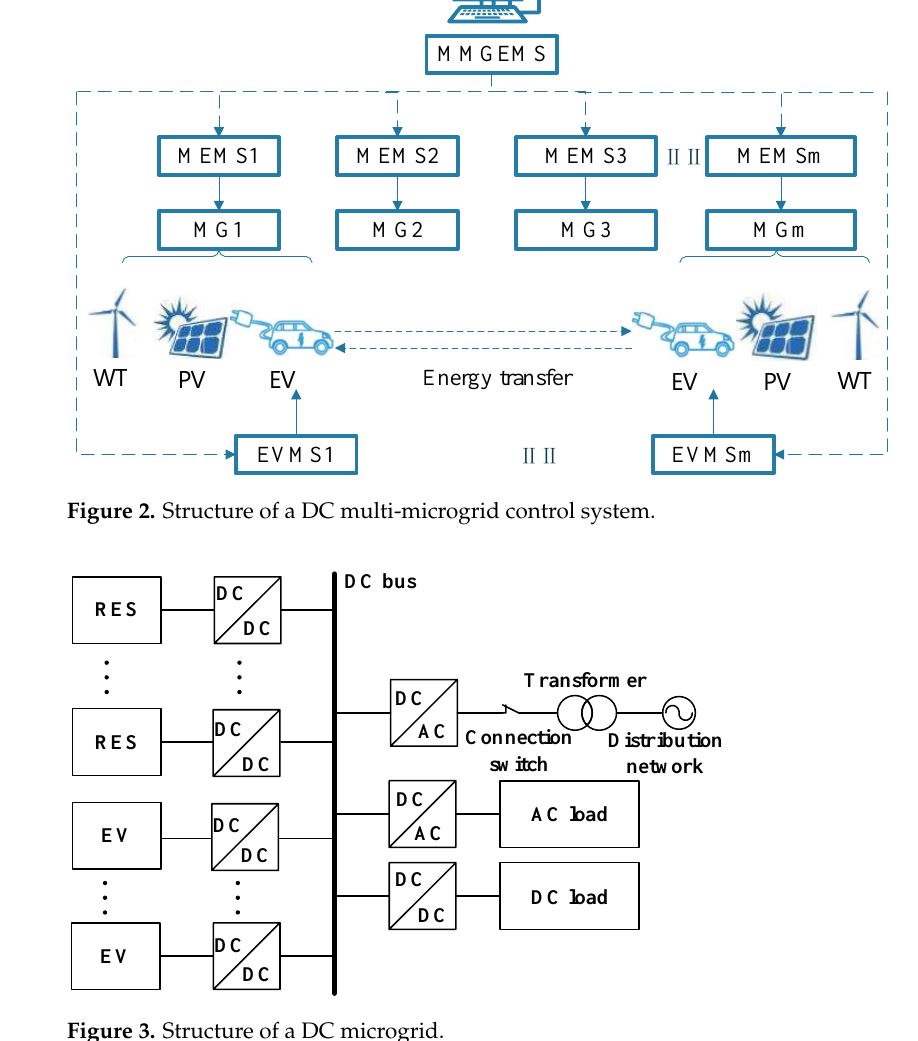
Figure 3. Structure of a DC microgrid.